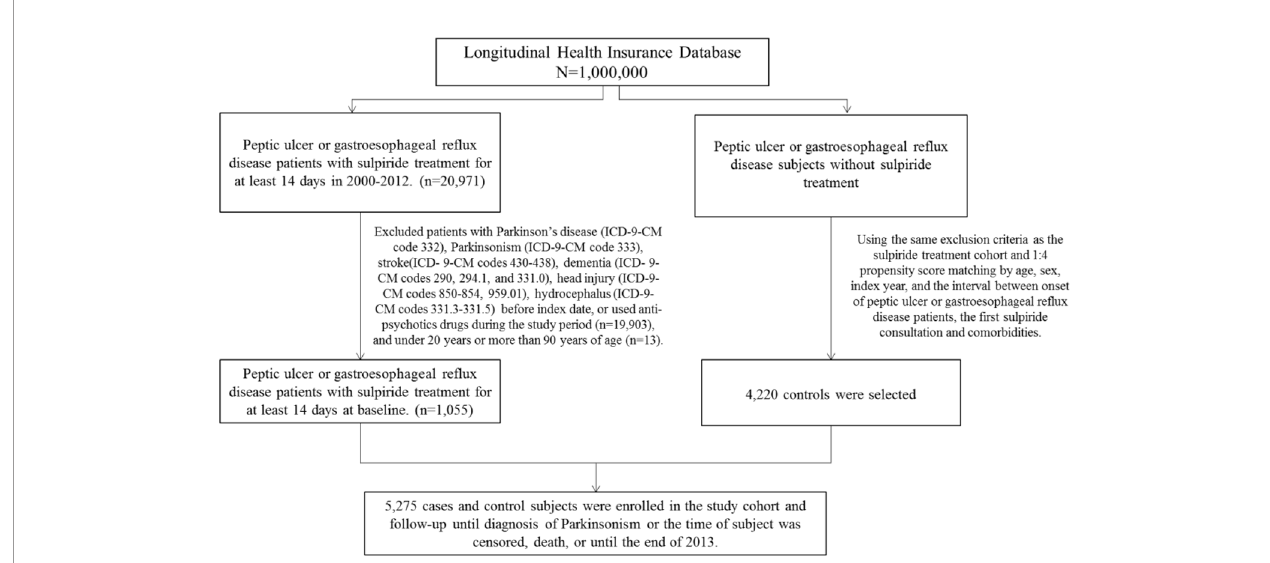
FIGURE 1 | Selection process of patients in the two study